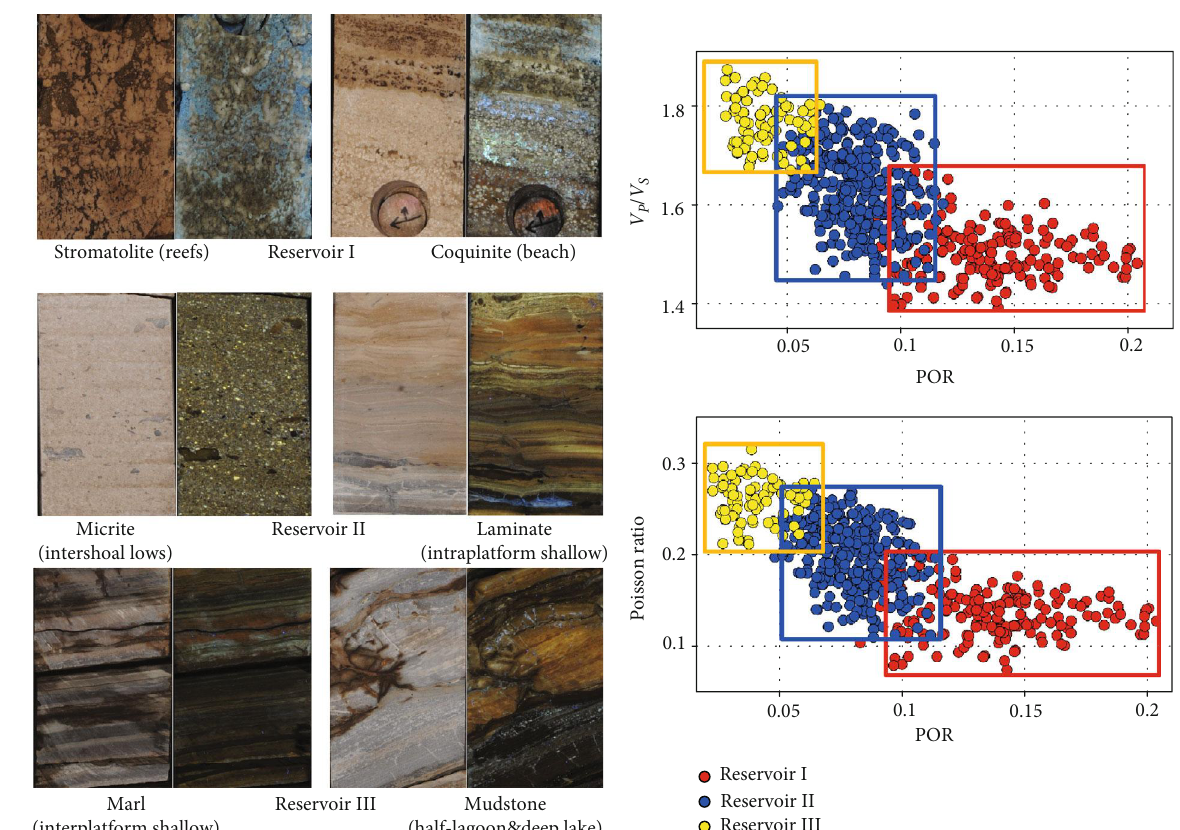
/ V ’ s ratio intersection P S and Poisson